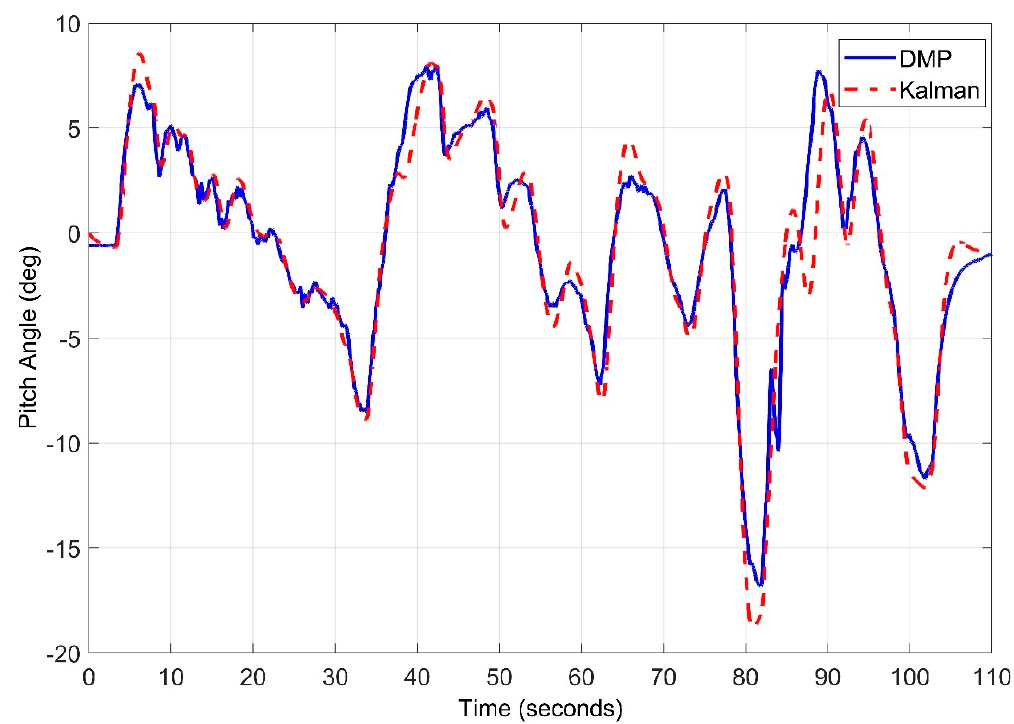
Figure 30. Real Time Pitch Angle Estimate for Kalman Filter.